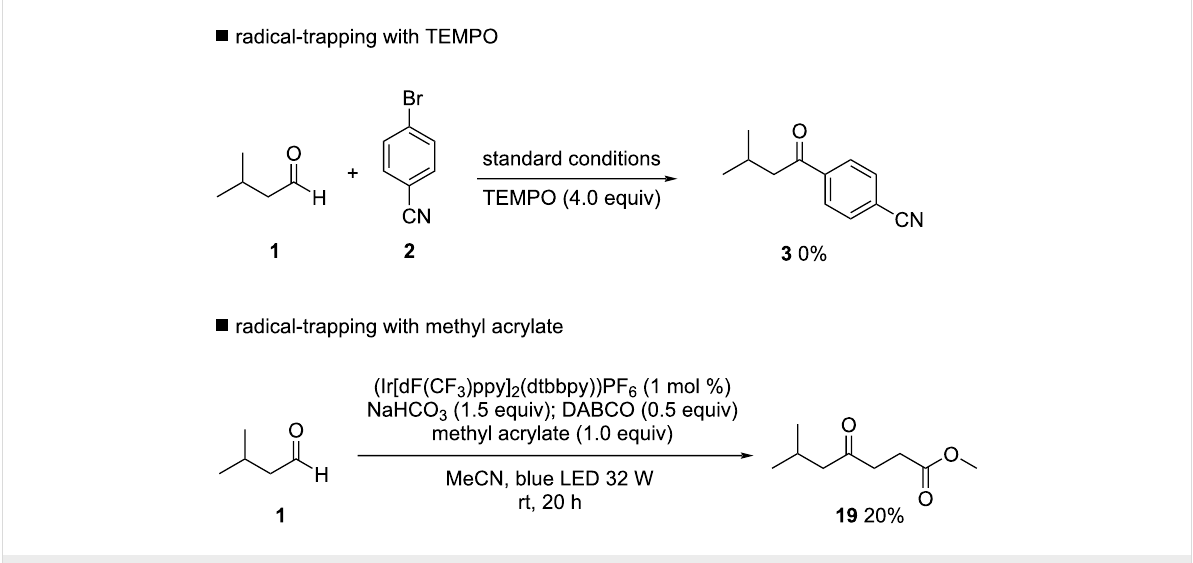
Scheme 2: Mechanistic investigations of the HAT reaction using